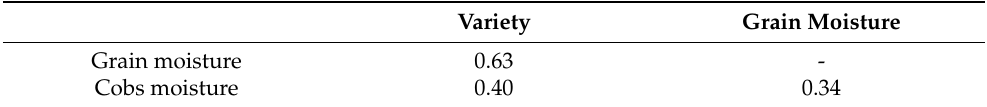
Table 2. Correlation between the FAO earliness and the moisture of grain and cob cores. Variety